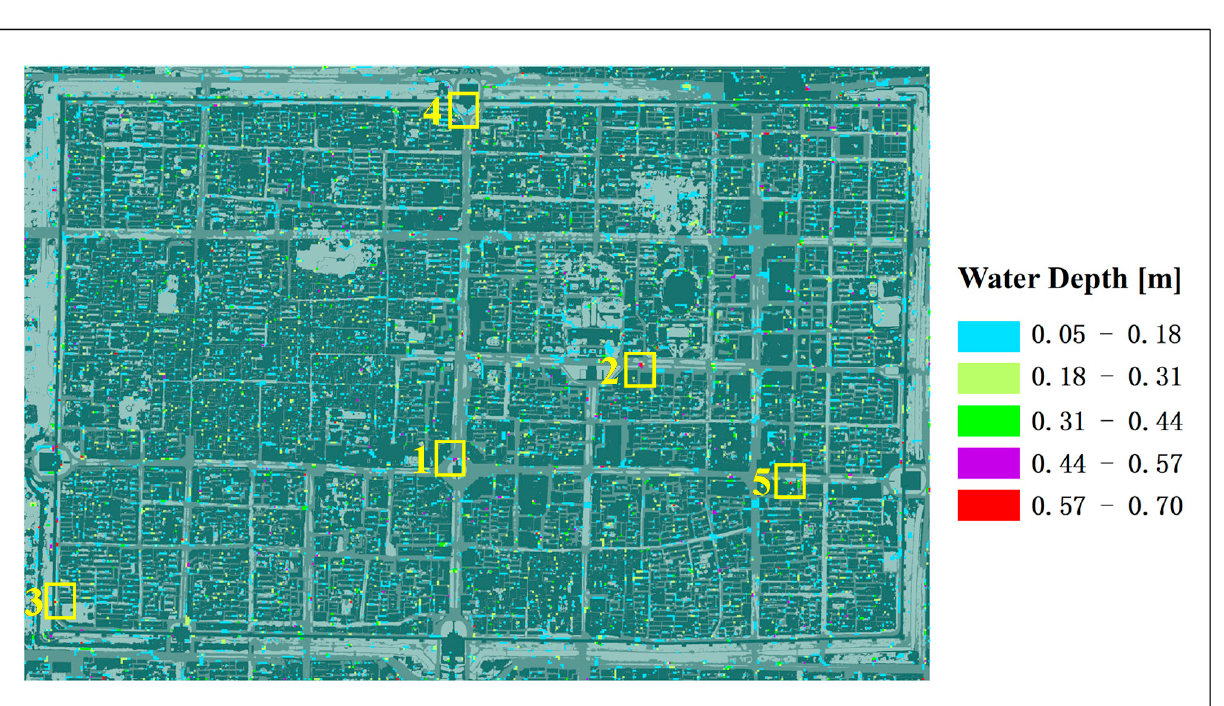
Table 5. Validation results of flood points in the study area on 24 July 2016.